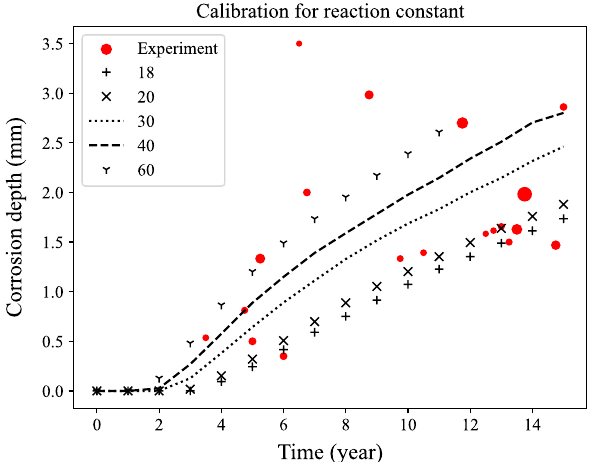
Figure 7. Calibration of reaction constant with measurement data 37